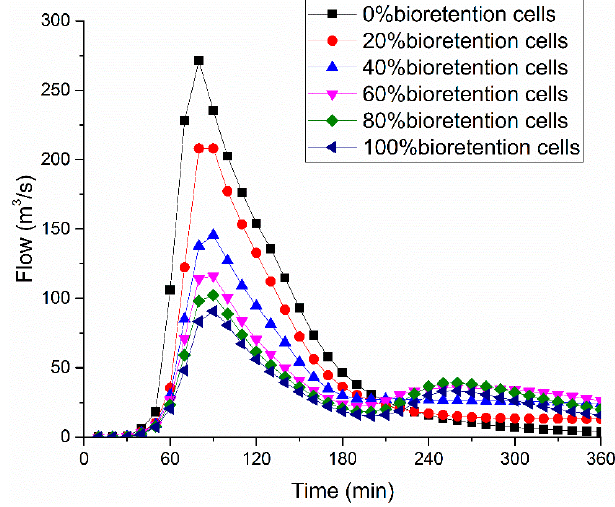
Figure 10. Outlet flow with different proportions of bioretention cells (P = 10 rainfall).